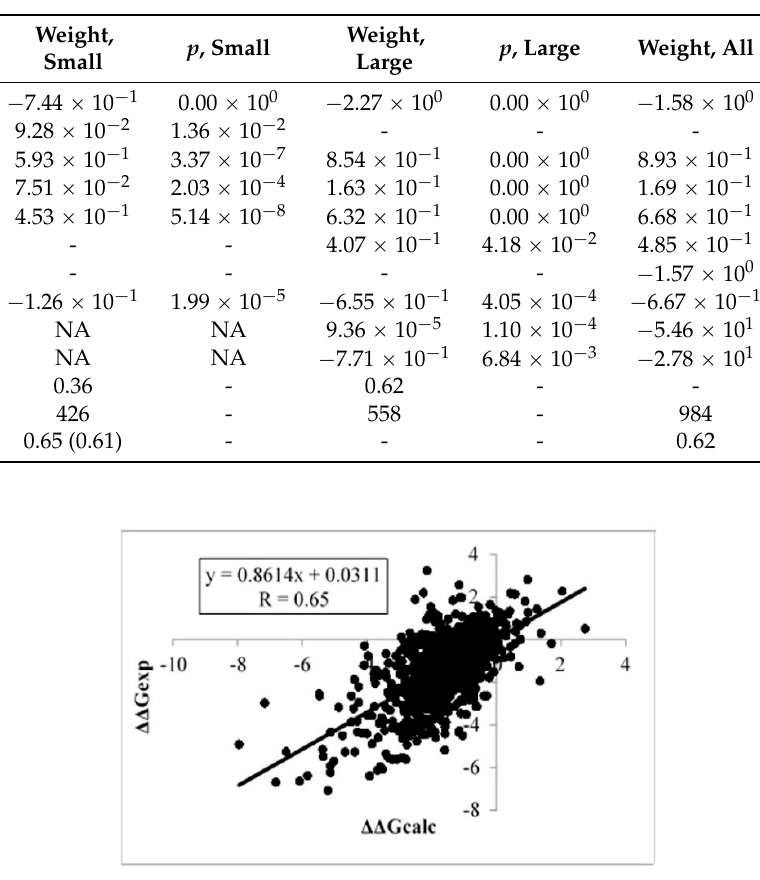
Table 3. The optimized weights and the corresponding p -values of the multiple linear regression analysis between calculated and experimental values of the change of folding free energy. The correlation coefficient R is reported separately for “small” and “large” effect cases. The bottom line, the R final , is reported for two cases: on the right for the entire database without distinguishing the cases of “small” and “large” effect, and on the left applying Equation (3) to predict the corresponding probabilities and then to apply Equations (11) and (12), respectively. The correlation coefficient in parentheses is obtained via 5-fold cross-validation.